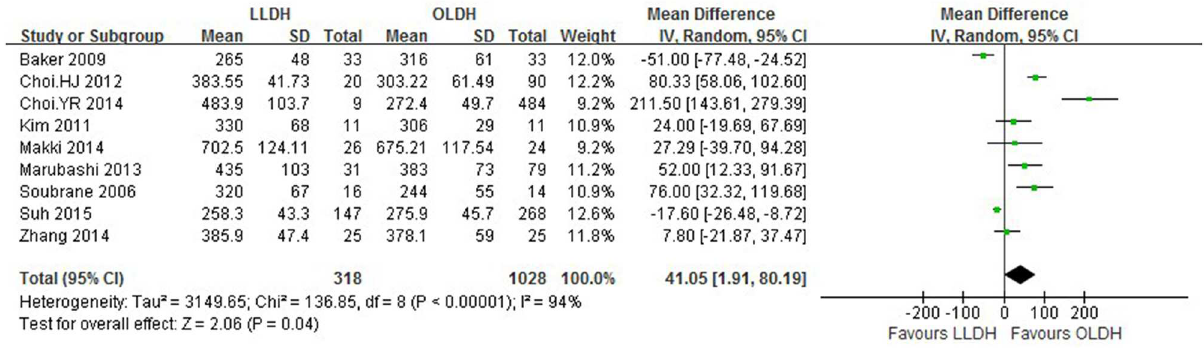
Fig 2. Forest plot displaying the results of the meta-analysis on operative